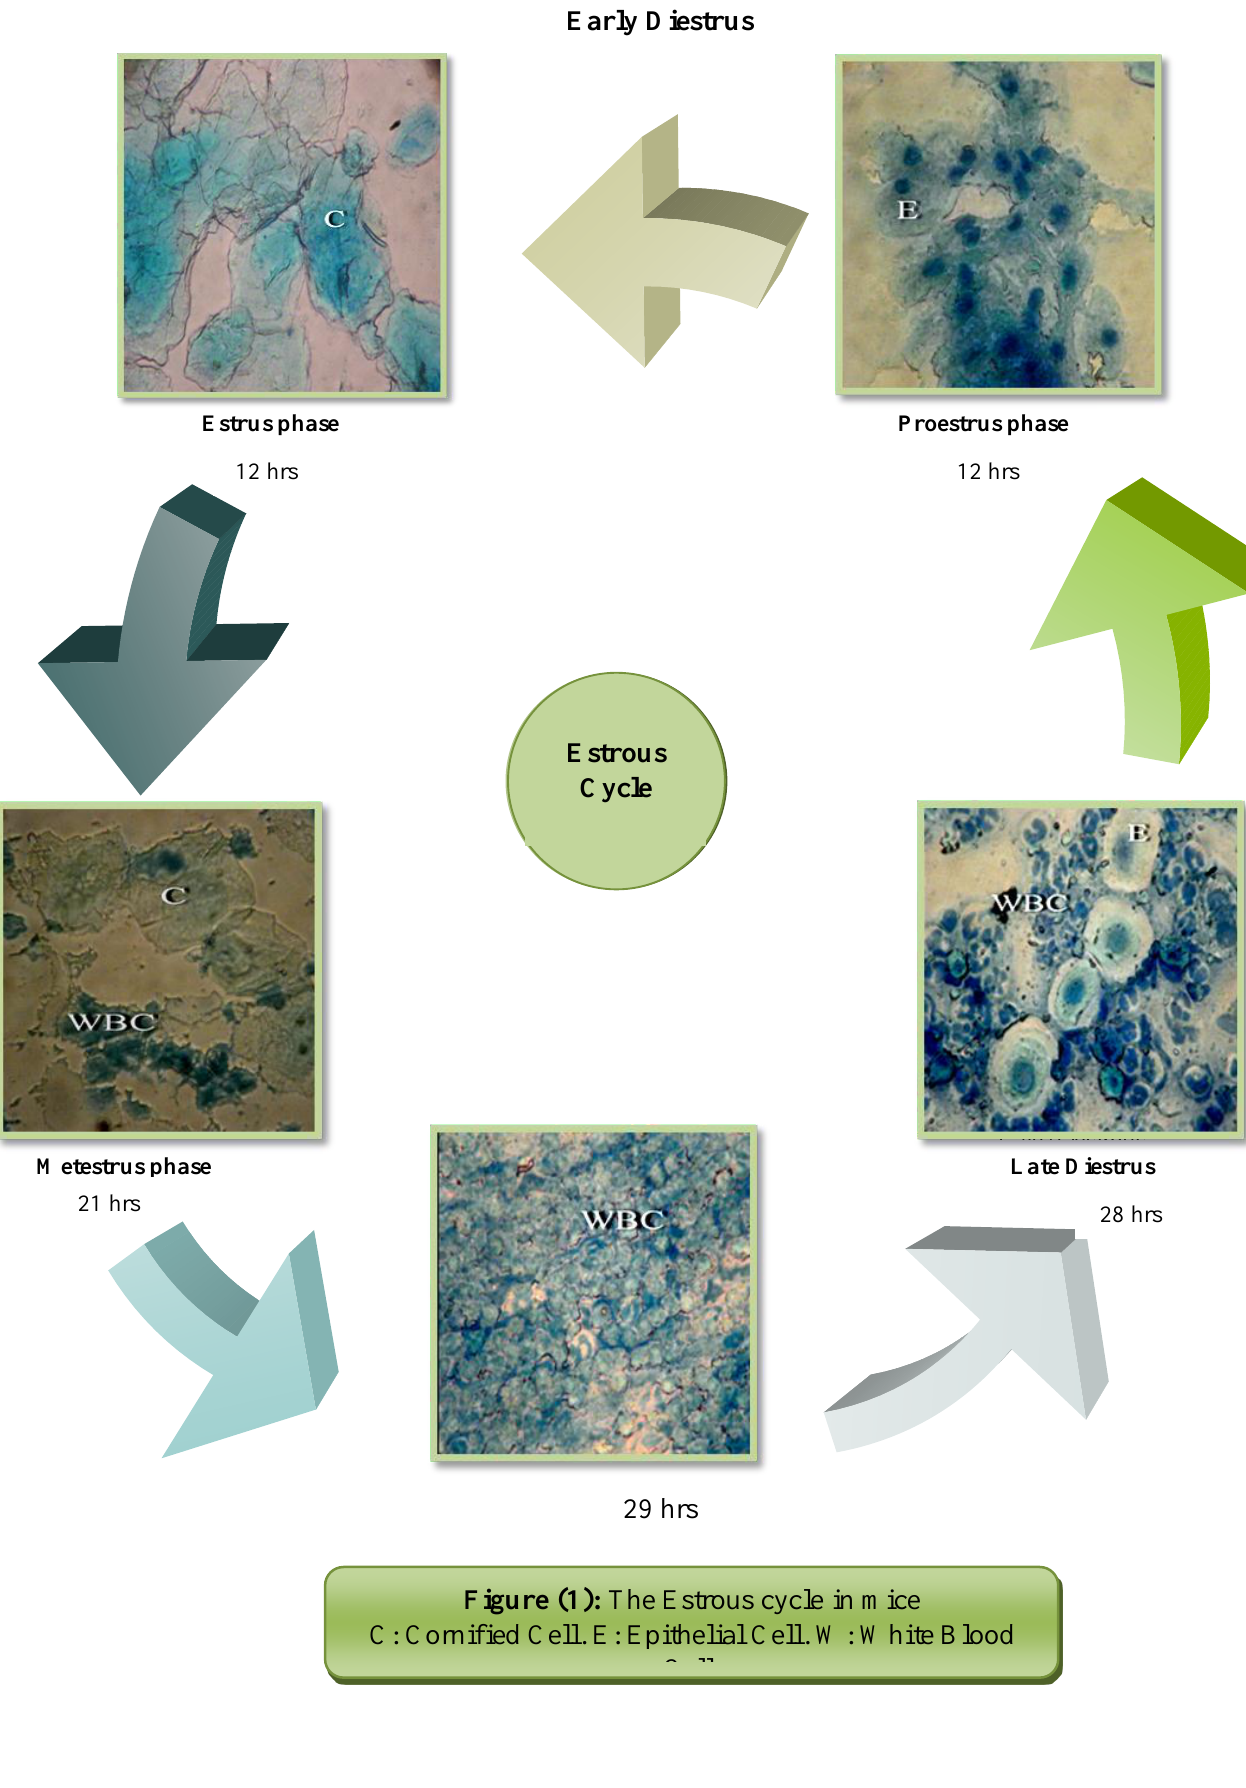
Figure (1): The Estrous cycle in mice C: Cornified Cell. E: Epithelial Cell. W: White Blood